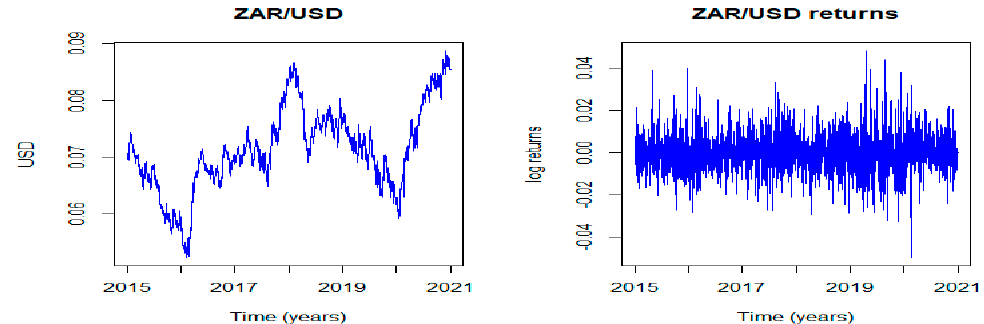
Figure 2. Plot of ZAR/USD prices ( left ) and one-day log returns ( right ). Descriptive Statistics